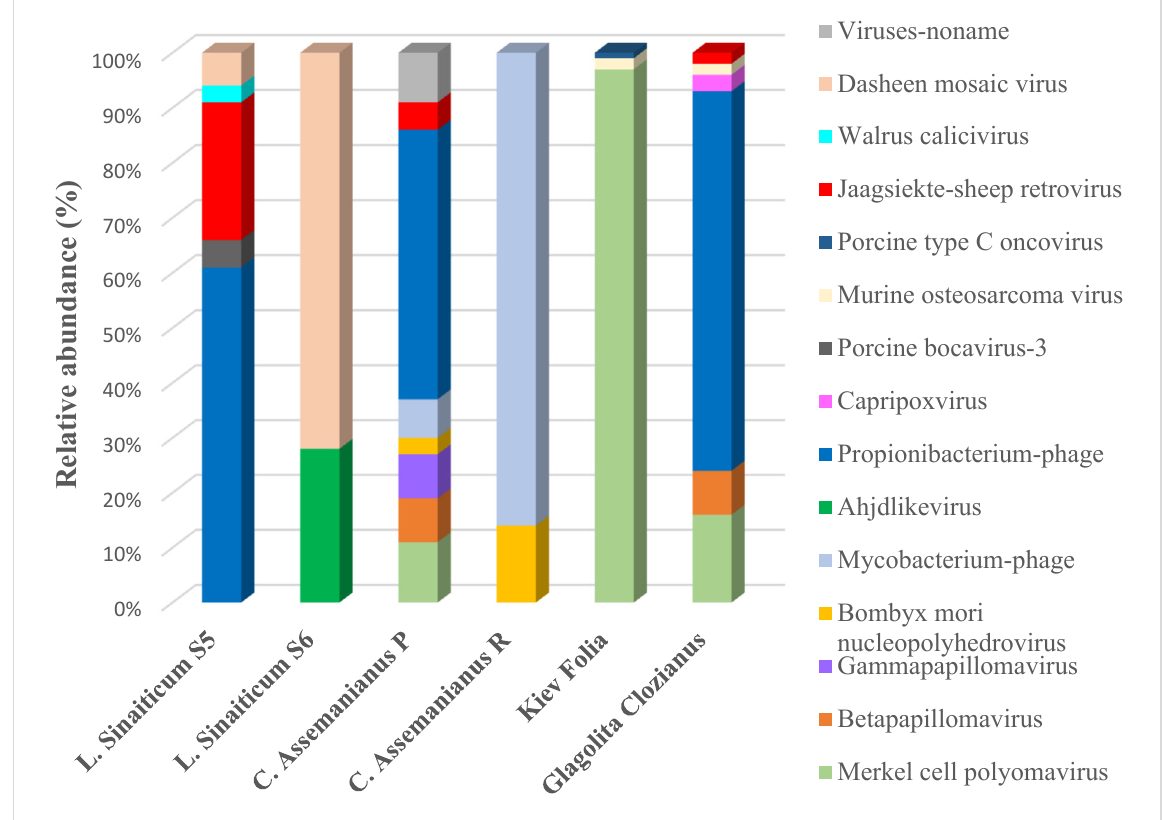
Figure 9. Shotgun metagenomics showing the relative abundance (%) of viruses in the microbiomes of ancient Slavonic codices [3,8] (and in Glagolita Clozianus , this study). The overall relative abundances of the viruses in the microbiomes were: L. Sinaiticum S5: 3%; L. Sinaiticum S6: <1%; C. Assemanianus P: 15%; C. Assemanianus R: <1%; Kiev Folia: 53%; Glagolita Clozianus : 11% (This study).